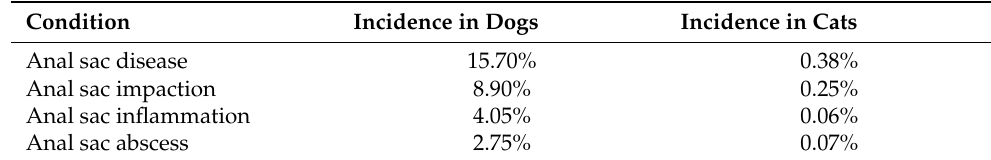
Table 1. Incidence of anal sac disease and the subdivision between anal sac impaction, anal sac inflammation, and anal sac abscess in dogs and cats (based on 56 and 57 responses, respectively).